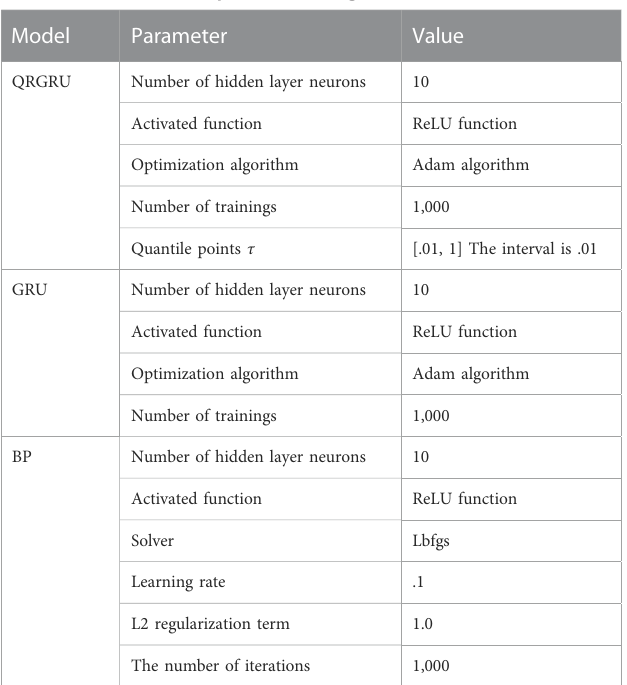
TABLE 2 Model and model parameter setting